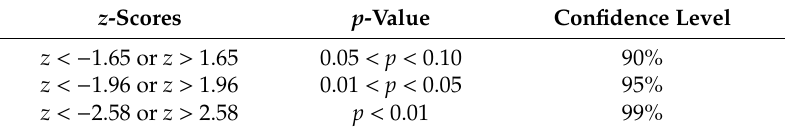
Table 1. Confidence level as a combination of z -scores and p